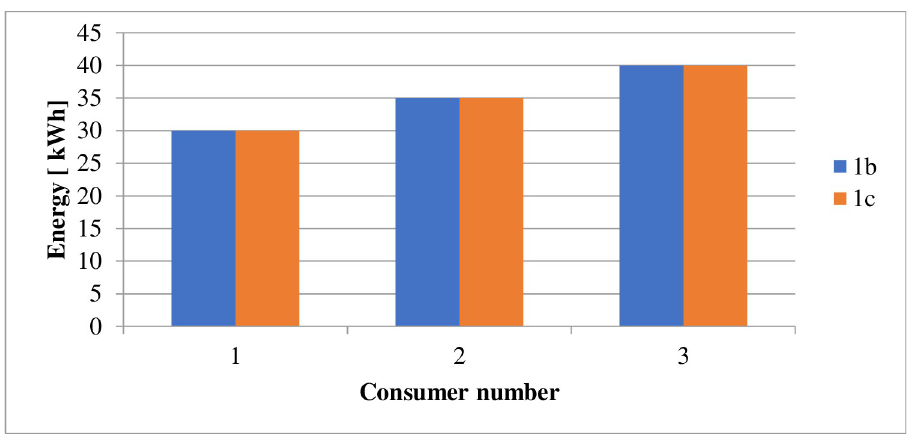
Fig 6. Power curtailed by consumers per day–case